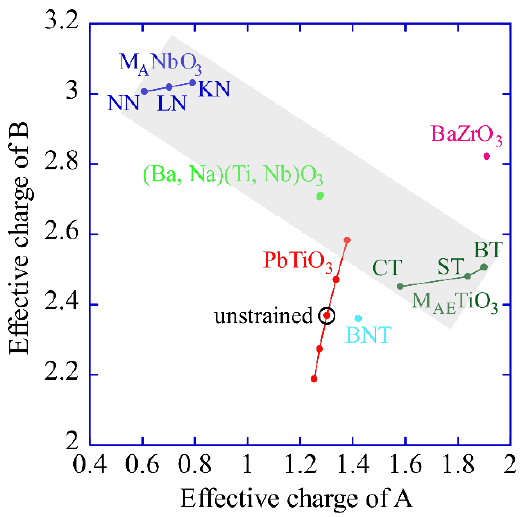
Figure 7. Map of the values in Tables 5–7 including those of BNT (Bi 1 / 2 Na 1 / 2 TiO 3 ) of the Na-centered model. LN, NN, KN are LiNbO 3 , NaNbO 3 , KNbO 3 . CT, ST, BT are CaTiO 3 , SrTiO 3 , and BaTiO 3 .